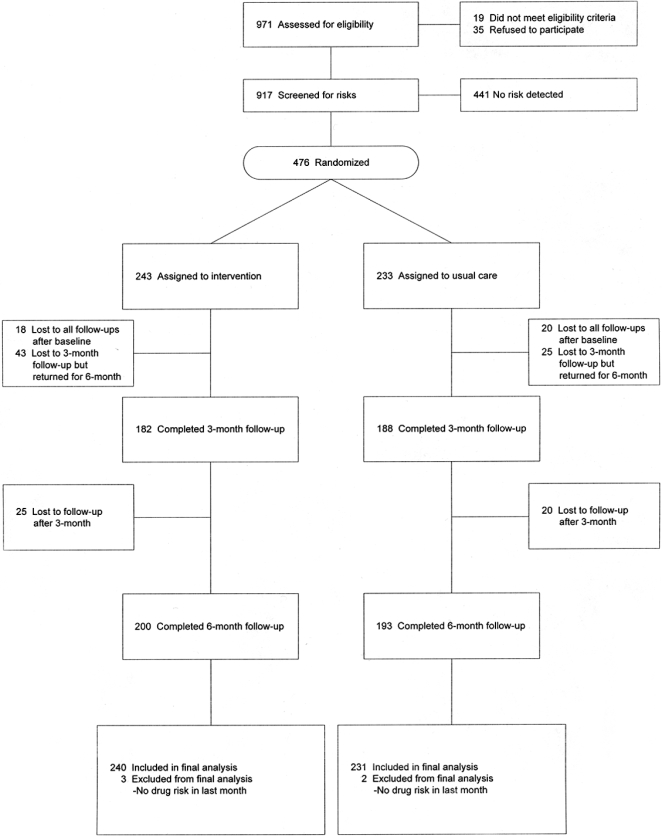
Flow of Positive Choice study participants